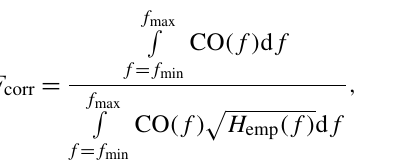
Figure 3. Flow chart of the data processing for the cumulative flux calculation using T of dataset D 2 . F PSA F REF are the cumulative fluxes corrected by following Fratini et al. (2012), in which F corr is calculated by implementing the time constants (for PSA: τ PSA and τ PSA ; for CSA: τ CSA √ ; for reference: τ LPF ) calculated in previous I07 A21 H, sync